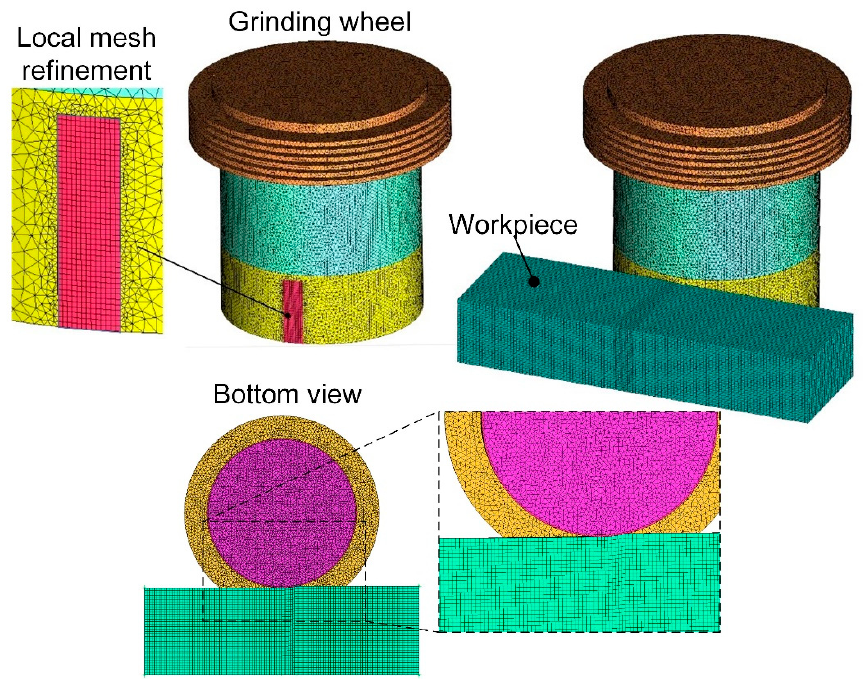
Figure 3. Mesh model.